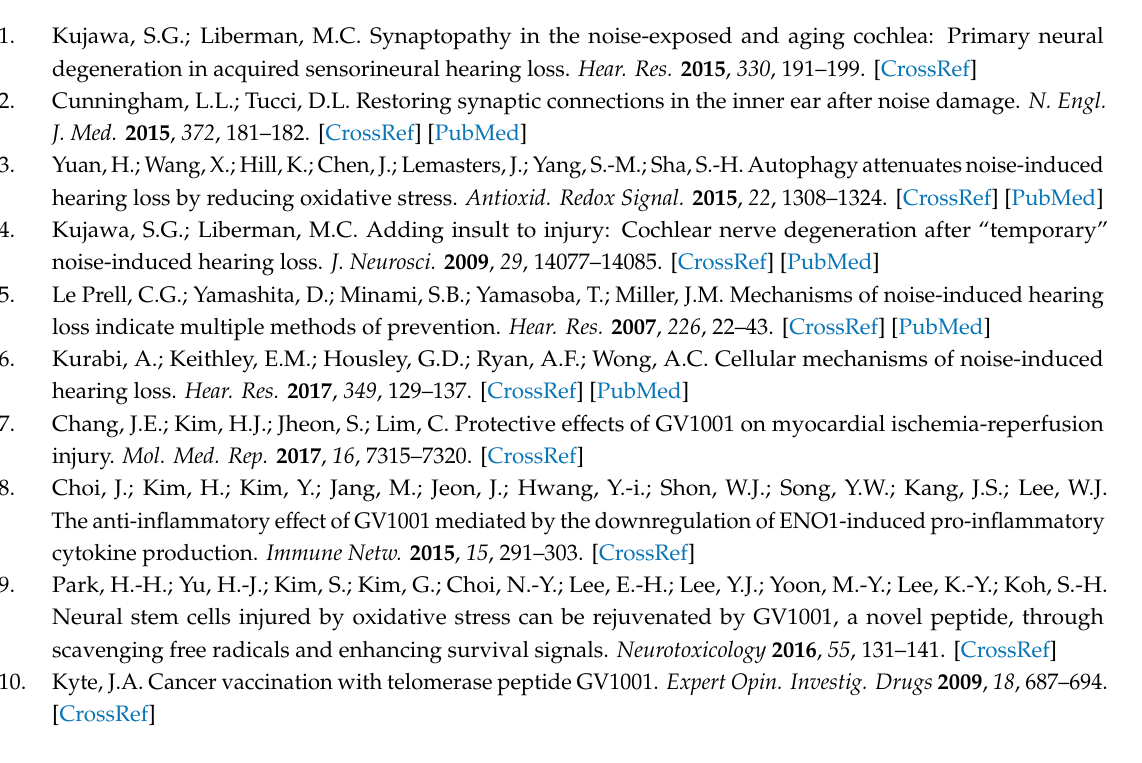
Figure S1: Preliminary data that explores the preventive role of GV1001 against the severe